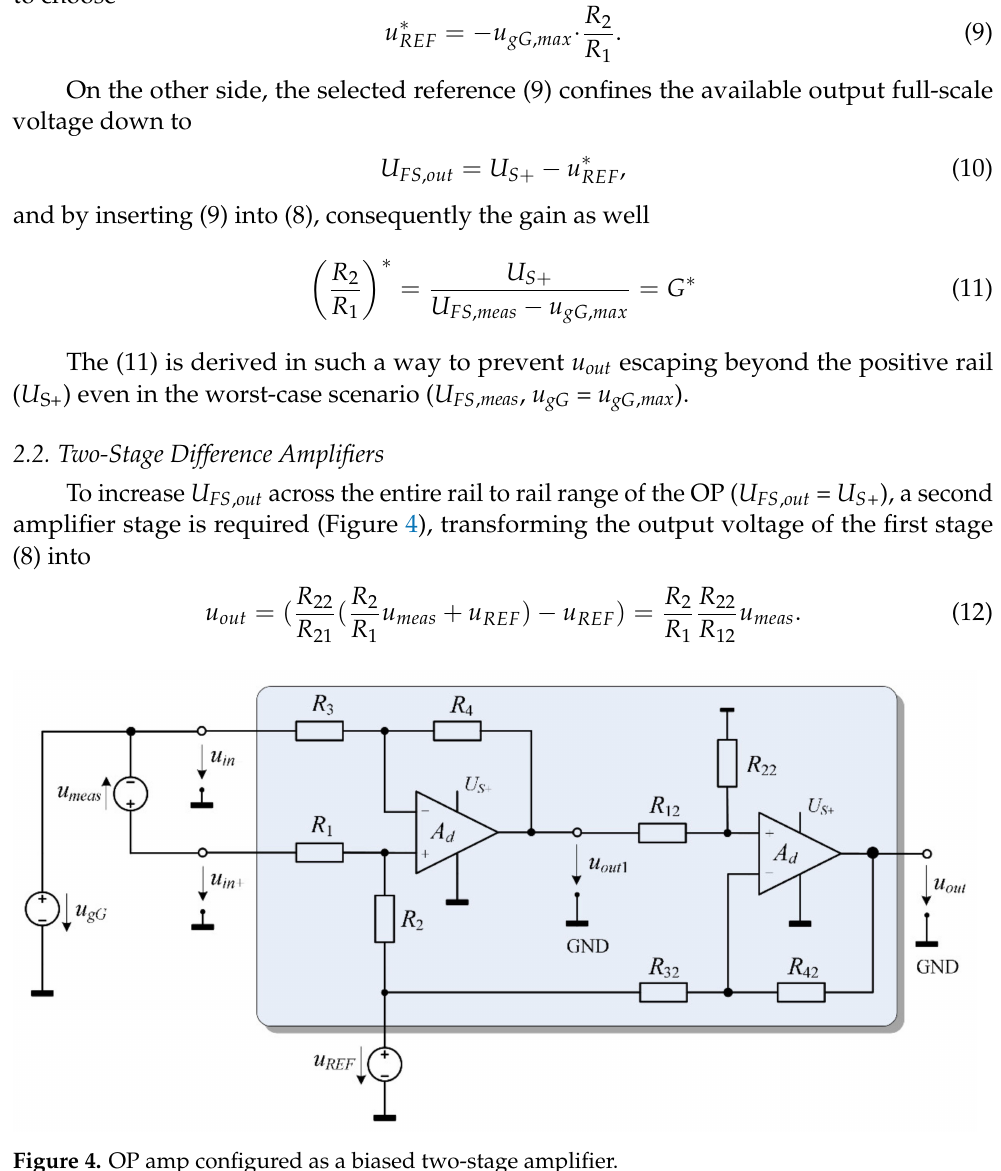
Figure 4. OP amp configured as a biased two-stage